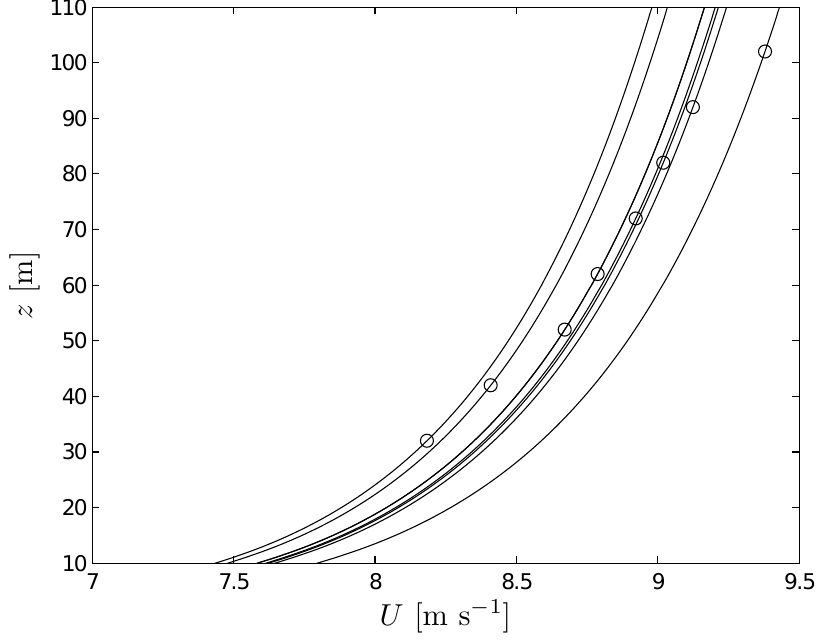
Figure 8. FINO-2 mean wind speed at eight levels observed from 1 August, 2007 to 31 July 2010 using 89,394 concurrent samples and logarithmic profiles extrapolated to 10 m from each of the eight observation heights.